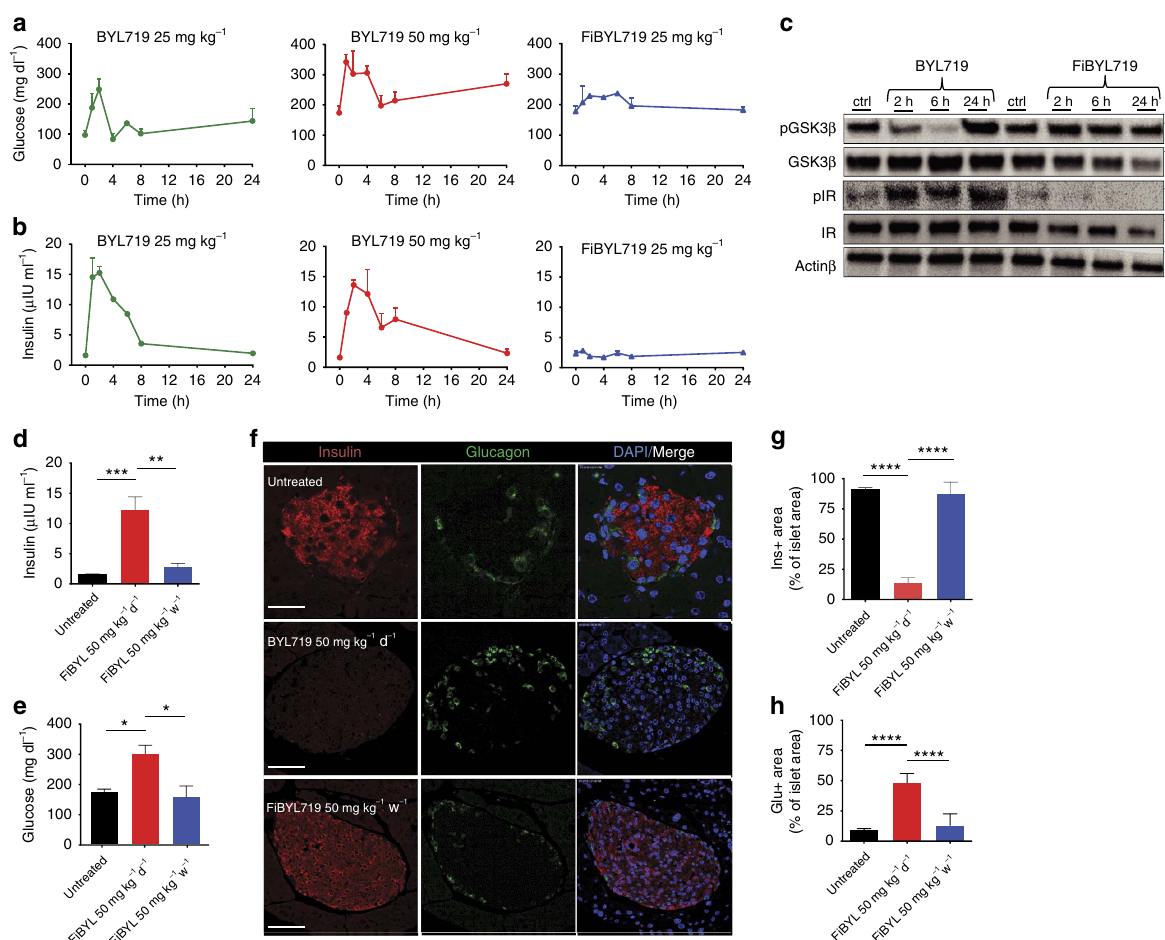
Figure 4 | Amelioration of systemic metabolic effects of PI3K inhibition by P-selectin-targeted delivery of BYL719. ( a , b ) Serum glucose and insulin levels of mice treated with 25 and 50mgkg (cid:2) 1 BYL719 or 25mgkg (cid:2) 1 FiBYL719 ( n ¼ 6). ( c ) Western blot of pGSK and pIR in mice livers following treatment with 50mgkg (cid:2) 1 BYL719 or 25mgkg (cid:2) 1 FiBYL719 ( n ¼ 6). ( d , e ) Serum insulin and glucose levels of mice following 60 days of treatment with 50mgkg (cid:2) 1 BYL719 daily or 25mgkg (cid:2) 1 FiBYL719 bi-weekly ( n ¼ 6). ( f ) Representative images of immunofluorescence staining for insulin (red), glucagon (green) and DAPI (blue) of mice pancreatic islets following 60 days of treatment with 50mgkg (cid:2) 1 BYL719 administered daily, or 25mgkg (cid:2) 1 FiBYL719 administered bi-weekly ( n ¼ 3). Scale bar, 50 m m. ( g , h ) Bar graph showing the percentage of insulin or glucagon positive staining areas of total tissue area from pancreatic islets ( n ¼ 3). In d , e , g , h , error bars indicate mean ± s.e.m. * P o 0.05, ** P o 0.01, *** P o 0.001, **** P o 0.0001; by one-way ANOVA with post hoc Tukey